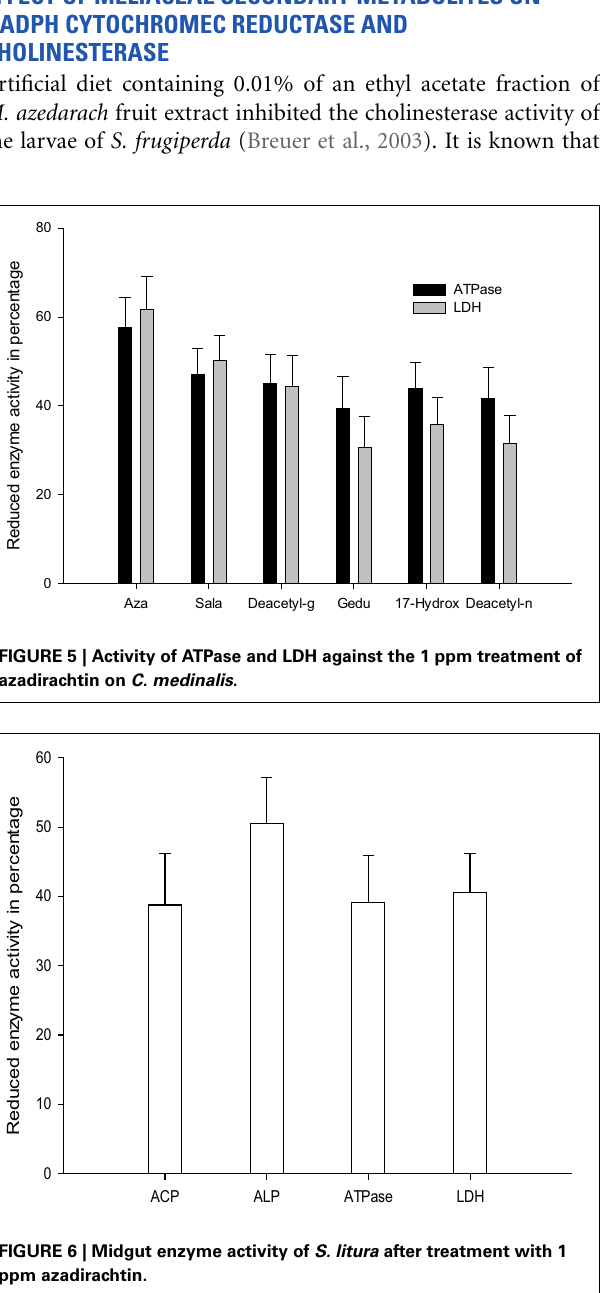
FIGURE 6 | Midgut enzyme activity of S. litura after treatment with 1 ppm azadirachtin.